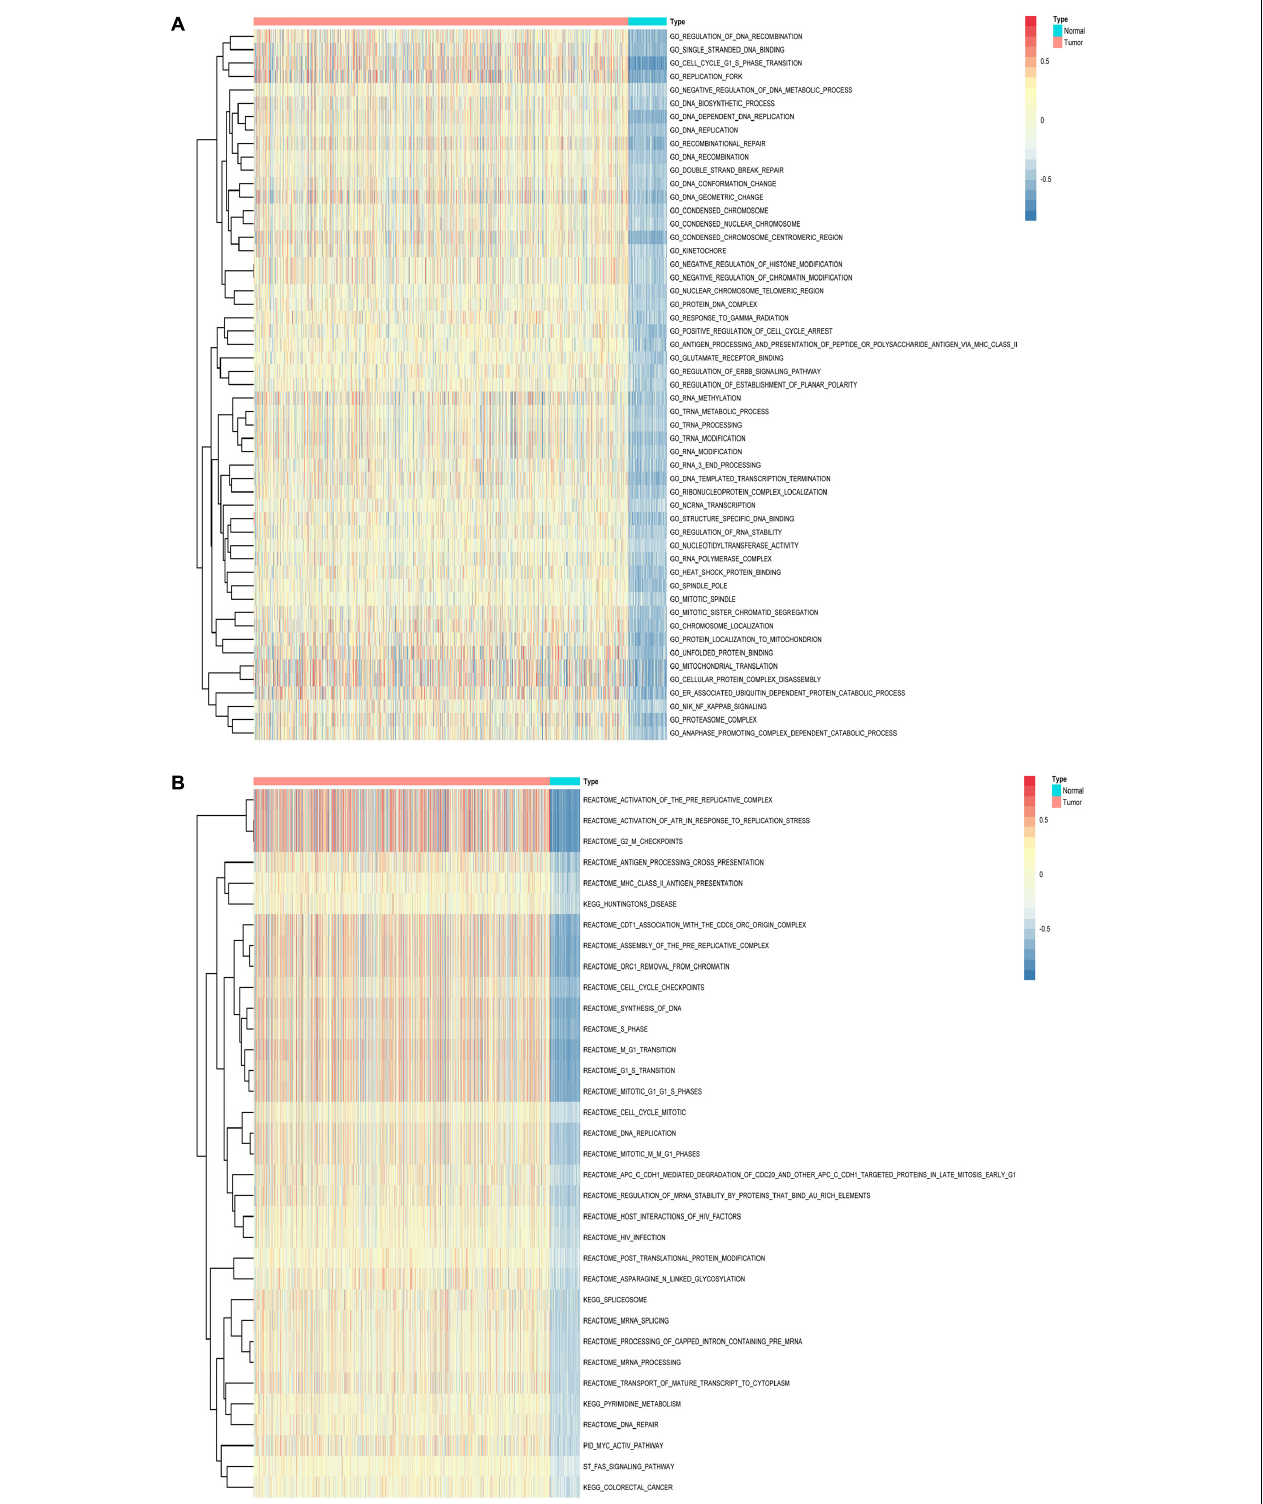
FIGURE 4 | Gene set variation analysis (GSVA) results with hierarchical clustering on parent genes from survival-related AS events in BRCA. (A,B) Heatmaps of upregulated differential enrichment results in BRCA tissue through GSVA of GO and Canonical pathways (KEGG, Reactome, and BioCarta pathway database) from MSigDB. Color transition from blue to red indicates the increasing enrichment score of BRCA